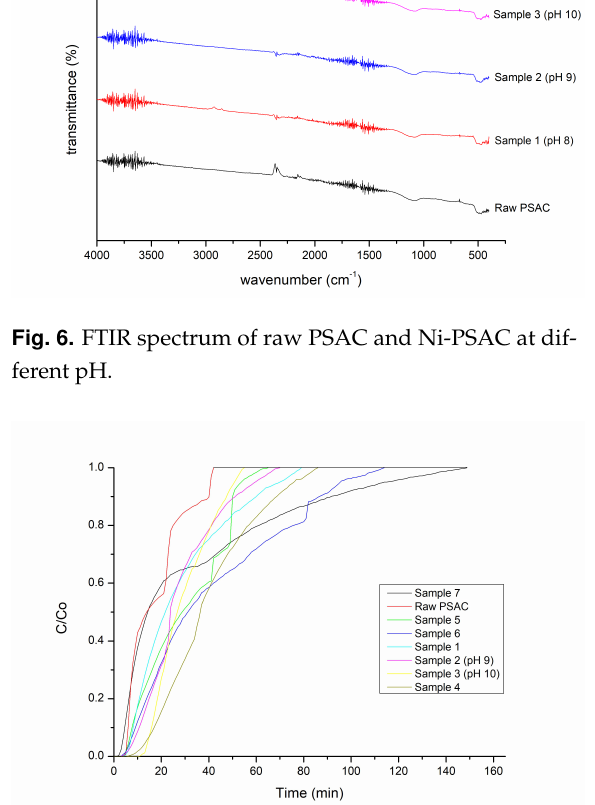
does strongly promote the removal of H 2